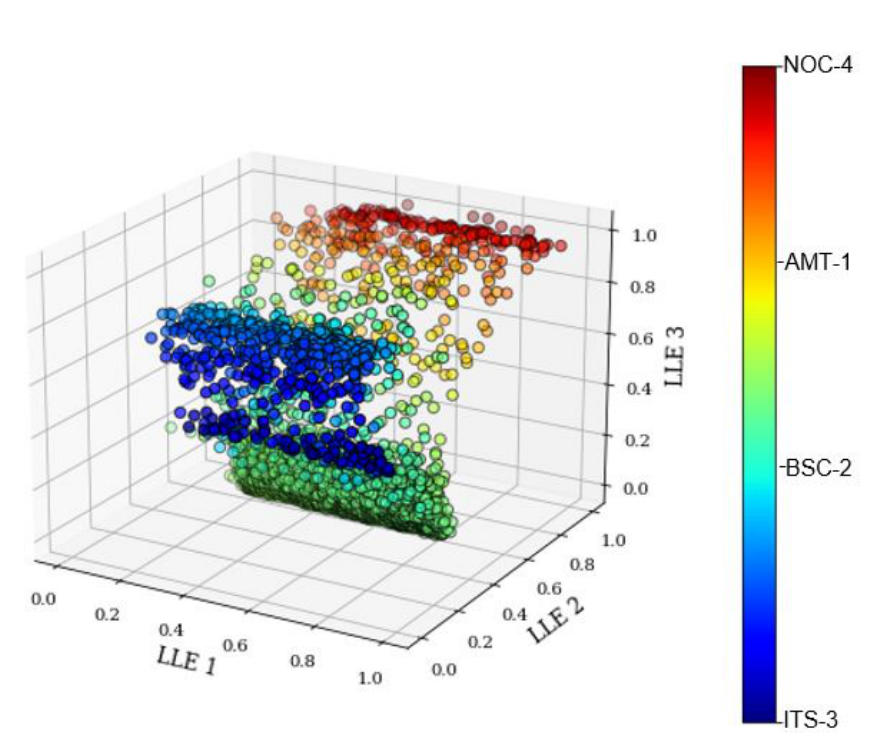
Figure 11. A three-dimensional LLE visualization of the discriminant features.